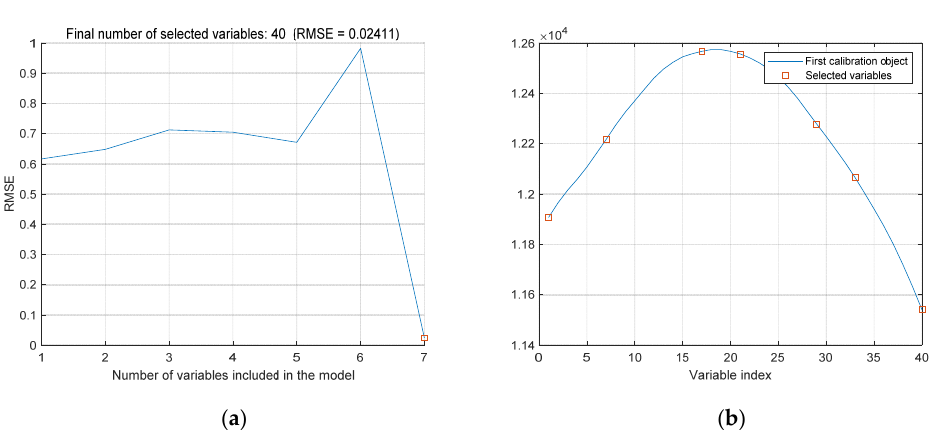
Figure 8. The characteristic wavelength selection results of the SPA algorithm at 695–796 nm in the CARS-SPA algorithm: ( a ) number of selected variables included in the model; ( b ) index of selected variables.